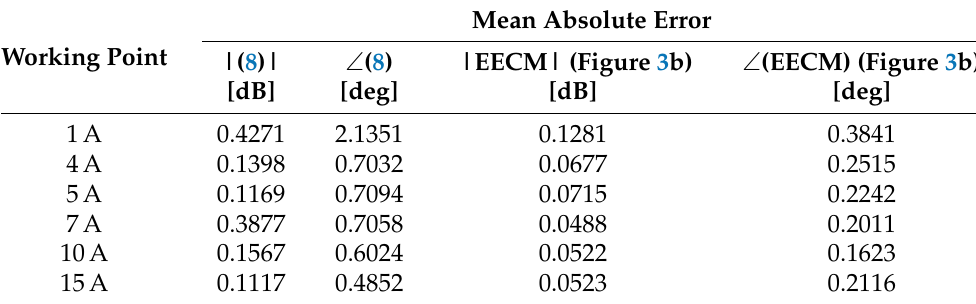
Table 3. The Mean Absolute Error (MAE), calculated for each current. For 7A, MAE was calculated using the interpolating laws described in (10)–(12) for the FOTF